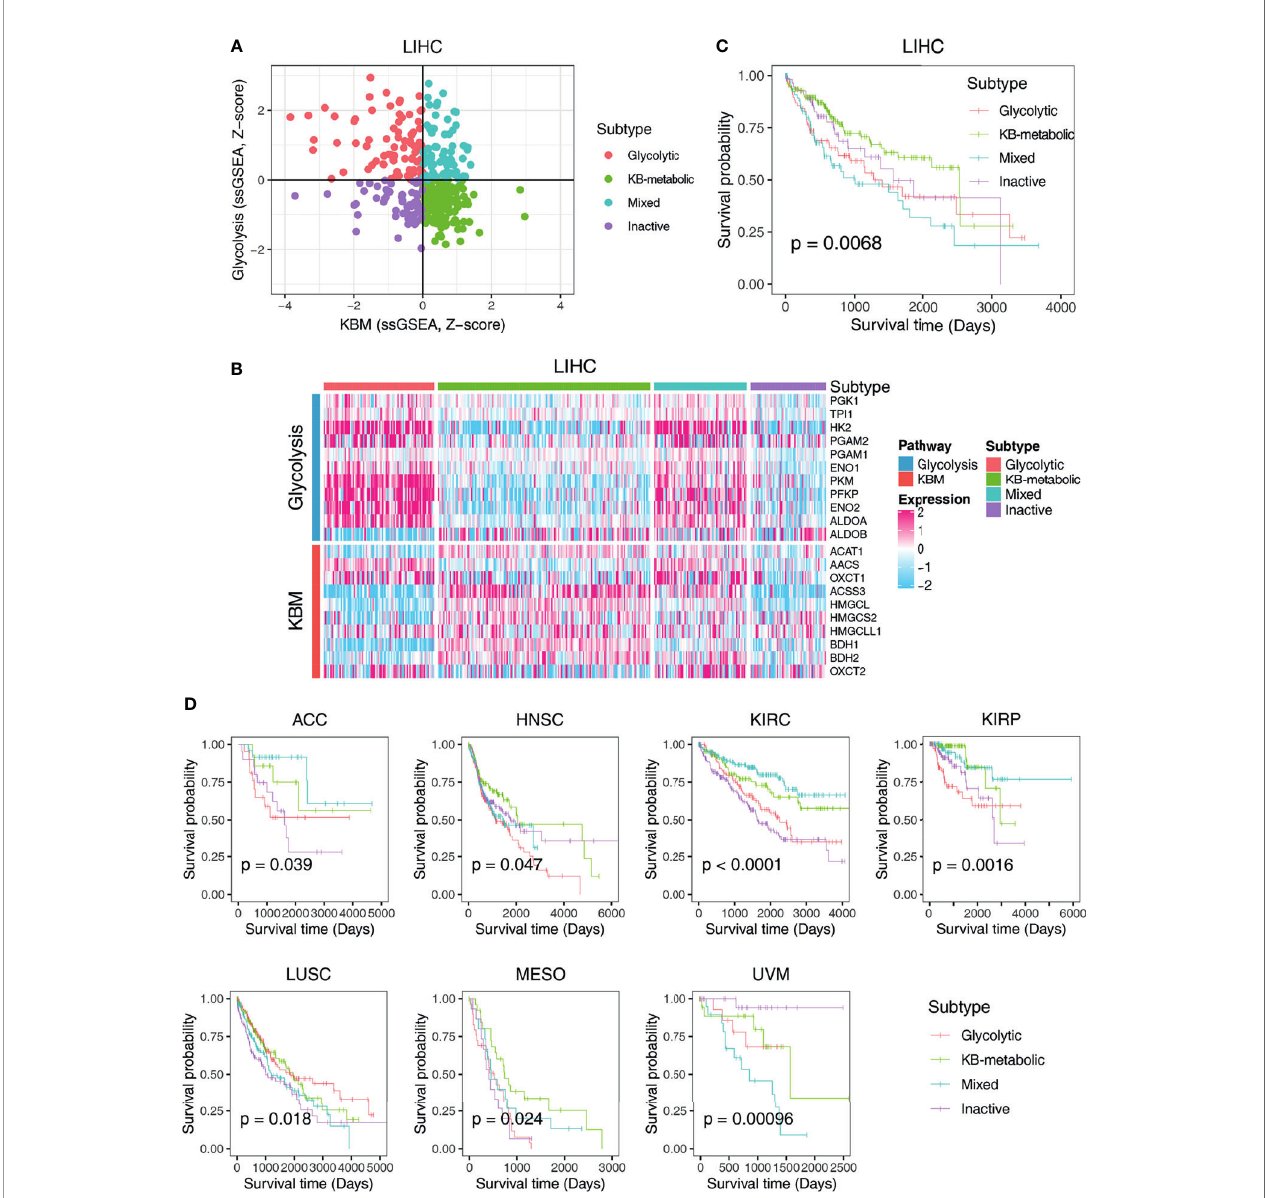
FIGURE 3 | Classi fi cation of metabolic expression subtypes and their associations with patient survival time. (A) Scatter plot of the ssGSEA score of KBM (x-axis) and glycolysis (y-axis) genes in each LIHC sample. Metabolic subgroups were assigned based on the relative levels of glycolysis and KBM genes. (B) Heatmap showing the expression pattern of glycolysis and KBM genes in each subtype. (C) Kaplan-Meier survival analyses of patients with different subtypes of LIHC. (D) The survival curves of different metabolic subtypes in different cancer types. The p-value was determined by log-rank